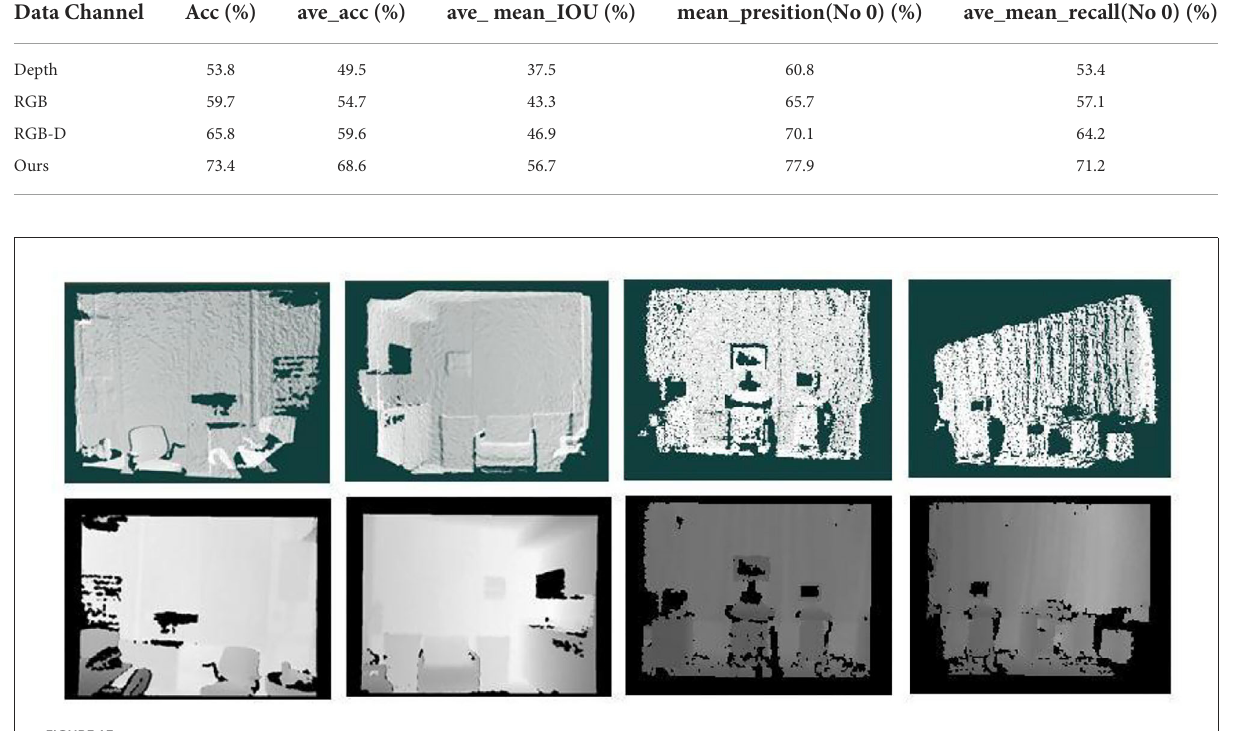
FIGURE13 Conversion of 3D point cloud data to 2D depth map